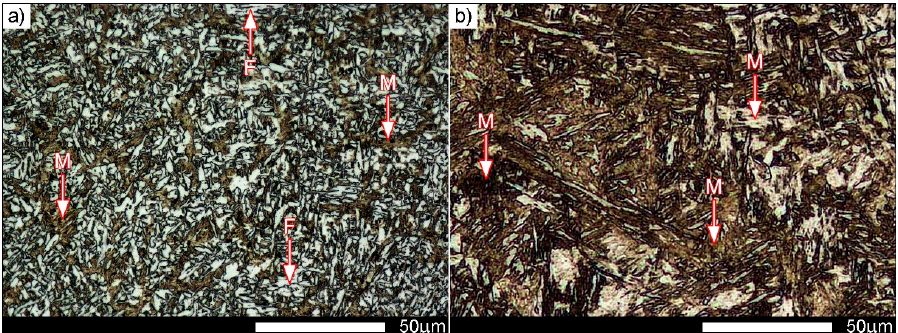
Figure 10. Microstructures of the Hardox 600 joint within weld metal zone—WM3 in Figure 3: ( a ) after welding; and ( b ) after welding and heat treatment. F—ferrite, M—martensite. Light microscopy, etched with 2% HNO 3 .